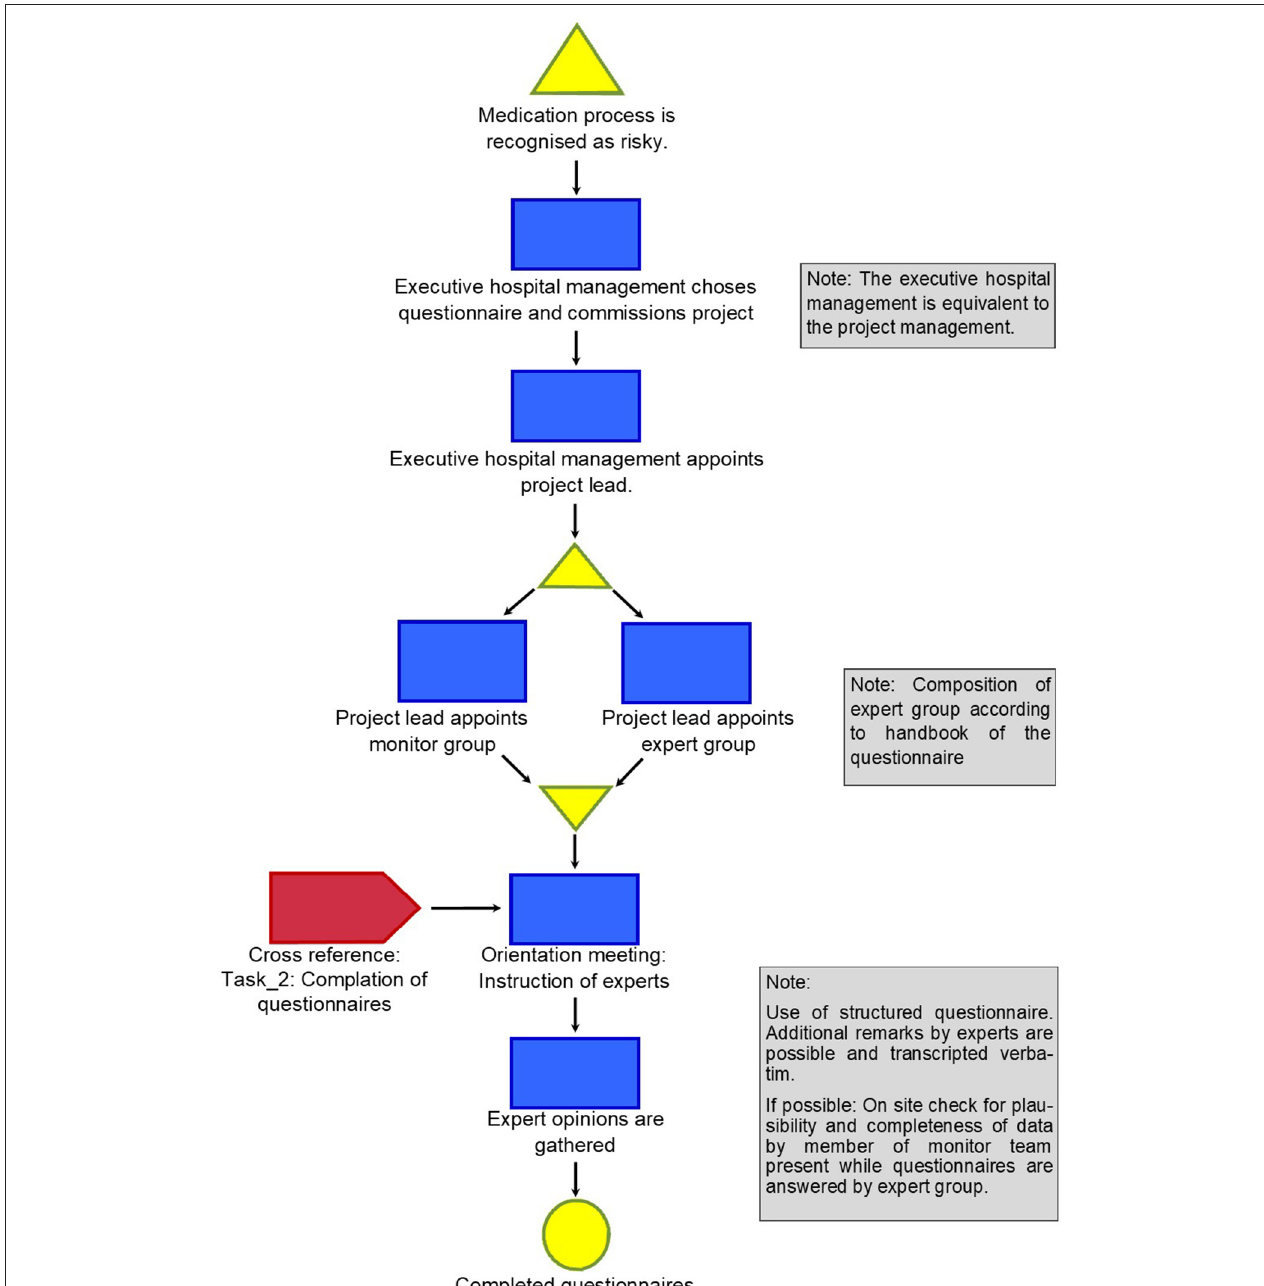
FIGURE 1 | Task_1: Initiating the project and getting individual answers to the